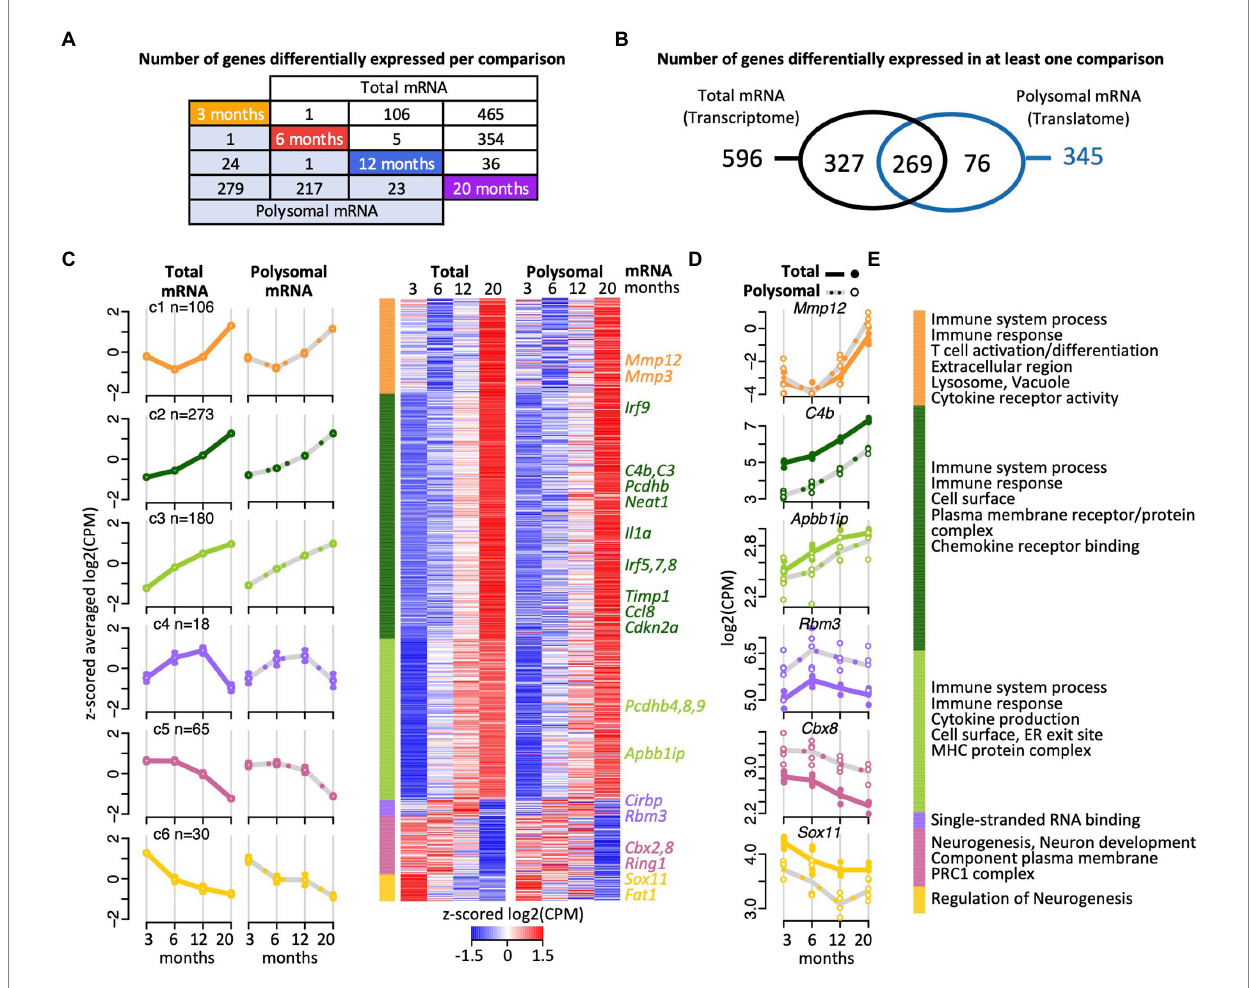
FIGURE 2 Gene expression trajectories in the transcriptome and translatome across four age groups identified with edgeR. (A) Scheme depicting the number DEGs in the transcriptome (total RNA) and translatome (polysomal RNA) across all pairwise time comparisons. (B) Venn diagram representing overlap of DEGs in the transcriptome and translatome. (C) Cluster heatmap and averaged temporal profiles of expression for the 672 DEGs identified in the transcriptome and translatome. The log 2 (CPM) values for each gene in a single age group were averaged to generate z-scored mean profiles, and six clusters (C1–C6; marked in different colors) were identified with the Bayesian Index Criterion based on the total RNA (transcriptome) data. The corresponding polysomal RNA (translatome) data are displayed to the right. The average profiles for each cluster are shown to the left with a continuous line for total RNA, a gray dashed line for polysomal RNA, and error bars showing 95% confidence intervals (CI). The number of genes within each cluster is indicated ( n ). (D) Expression levels (log 2 (cpm)) of selected genes. Total mRNA; solid line displays the mean and closed circle refer to individual samples. Polysomal mRNA; gray dotted line is the mean and open circles show individual values. (E) Enriched Gene Ontology (GO) terms for each cluster. The dataset with functional annotations is provided in Supplementary Table 2